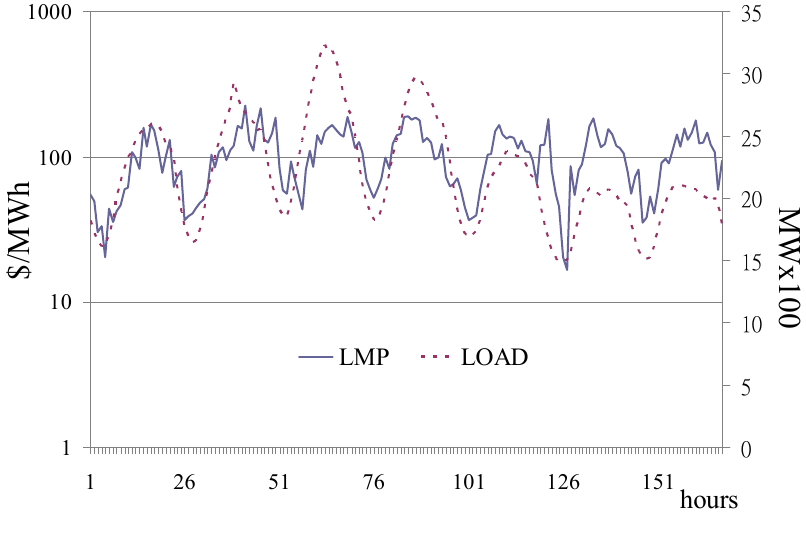
Figure 2. Daily LMPs in Byberry (13 kV) on 1–7 July